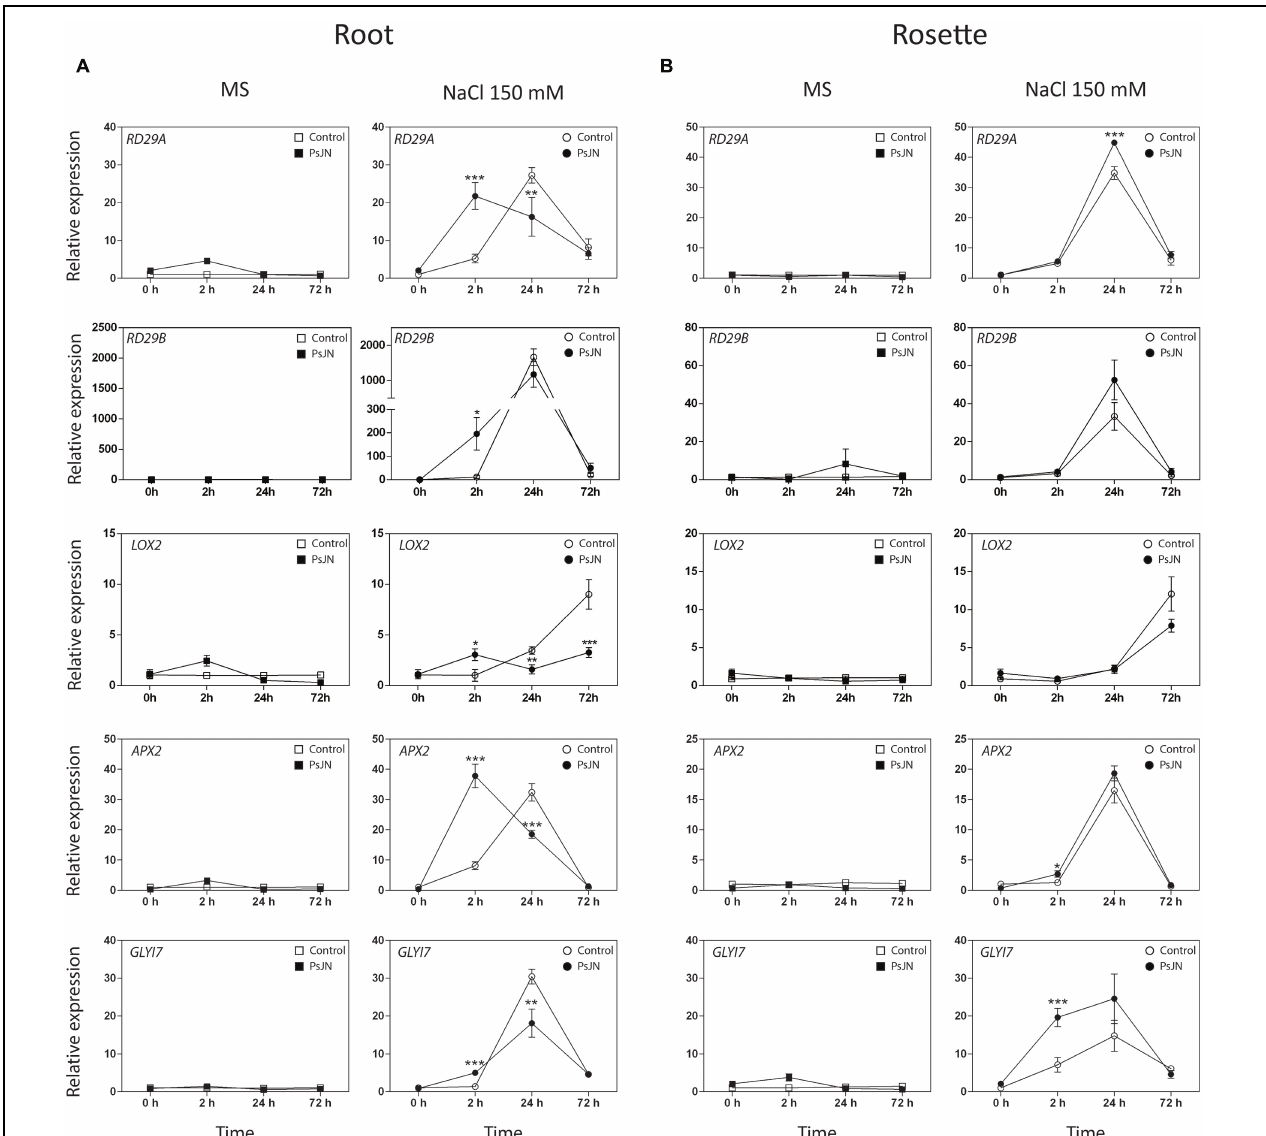
FIGURE 5 | Effects of B. phytofirmans on A. thaliana abiotic stress responsive genes. Quantitative RT-PCR determinations of relative expression levels of the genes: RD29A ( Responsive to Dessication 29A ); RD29B ( Responsive to Dessication 29B ); LOX2 ( Lipoxigenase 2 ); APX2 ( Ascorbate Peroxidase 2 ); GLYI7 ( Glyoxalase I 7 ) , in roots (A) and rosettes (B) of A. thaliana plants treated with or without strain PsJN,